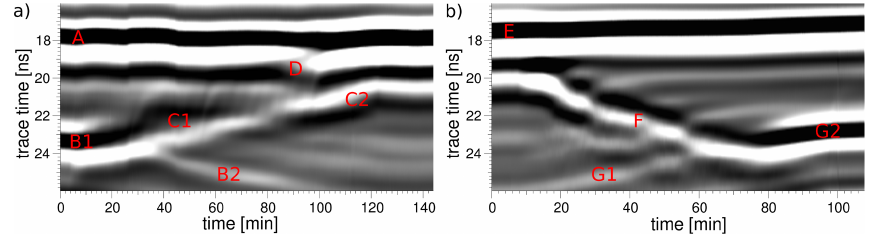
Fig. 2. Radargrams recorded during (a) imbibition and (b) drainage. The radargrams show the reflection from the layer boundary at 0.9m depth (A and E), the reflection from the compaction horizon at 1.2m depth (B and G) and the capillary fringe reflection (C and